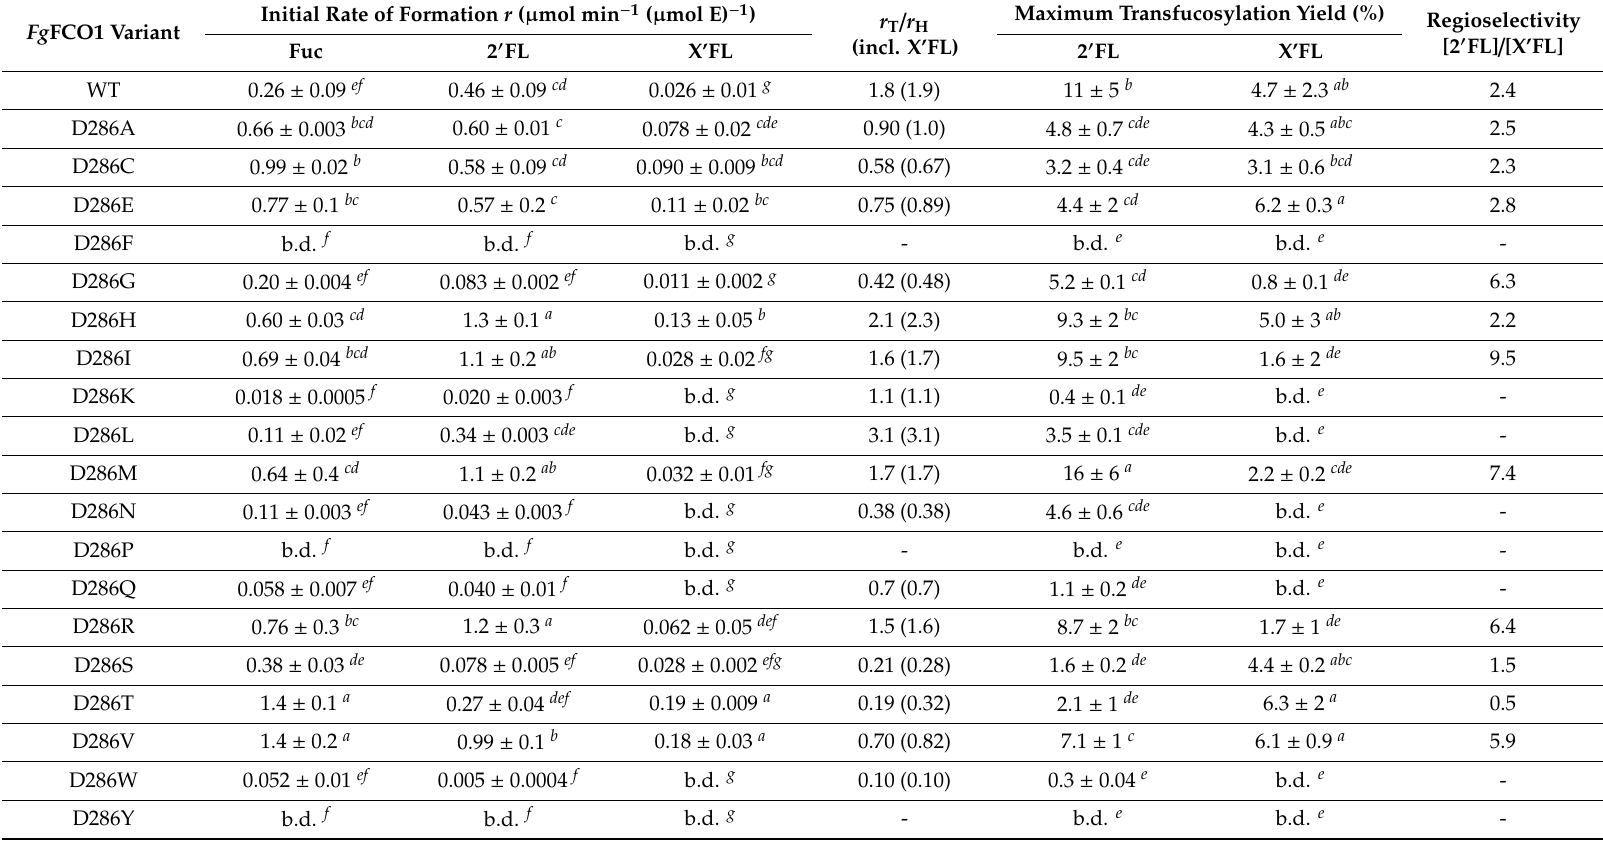
Table 3. Transfucosylation with D286 site-saturation mutagenesis (SSM) variants of Fg FCO1. Initial rates of formation ( r ) of fucose (Fuc), 2 (cid:48) -fucosyllactose (2 (cid:48) FL), and its regioisomer X’FL in the transfucosylation catalyzed by Fg FCO1 SSM variants of D286 using fucosylated citrus peel xyloglucan as the fucosyl donor and lactose as the acceptor over 24 h. The ratio between the transfucosylation rate ( r T ) and the hydrolysis rate ( r H ) is indicated: the first number is calculated for 2’FL alone, whereas the number in brackets includes the sum of FL isomers. Maximum molar yields on the donor substrate obtained during the 24 h of reaction are given for 2 (cid:48) FL and X’FL. For some enzyme variants, activity was below the HPAEC-PAD detection limit (b.d.) of the 0.05 µ M product, which equals a product yield of 0.0025%; these numbers were included in the statistical analysis. Superscript letters ( a – g ) indicate significant di ff erences between enzyme variants for each rate of formation or for yield of each product ( p < 0.05). Regioselectivity ([2 (cid:48) FL] / [X’FL]) is calculated at the highest yield of 2 (cid:48)